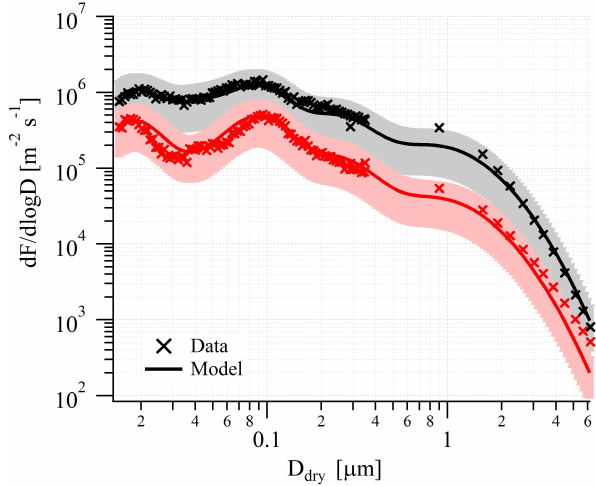
Fig. 4. (a) Parameterization of the size-dependent sea spray aerosol flux at Re H sured data points, the solid black line represents the parameterization and thin lines represent individual lognormal modes; (b) SSA flux versus Re H for the different size modes. Markers represent the measured data points, lines are the fitted power laws used in the parameteri- w zation (mode amplitudes F i , Table 1).